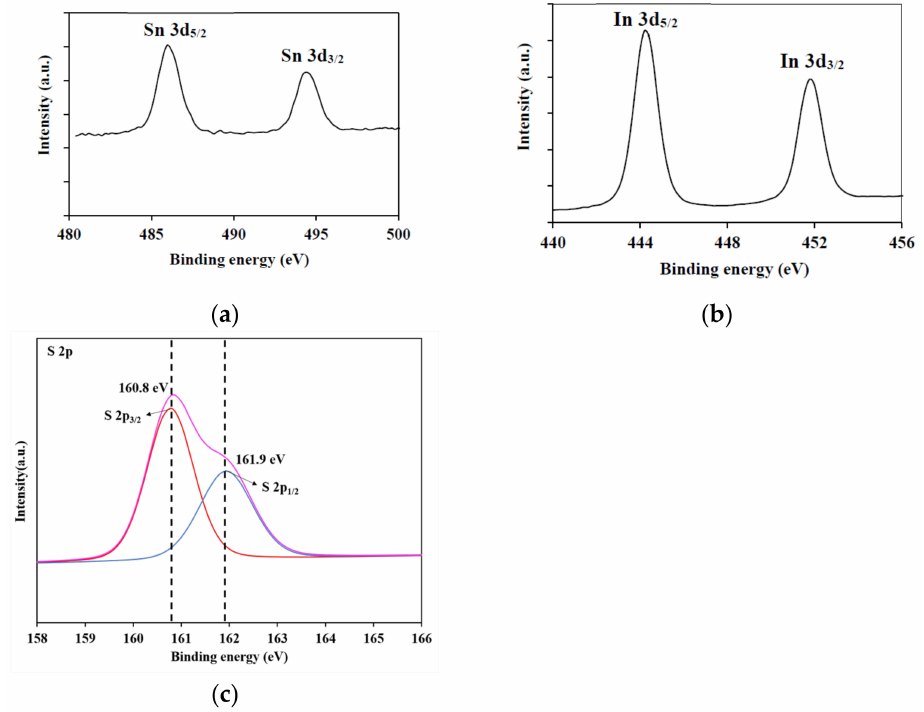
Figure 4. XPS spectra of the as-prepared SnIn 4 S 8 photocatalyst: ( a ) Sn 3d; ( b ) In 3d; ( c ) S